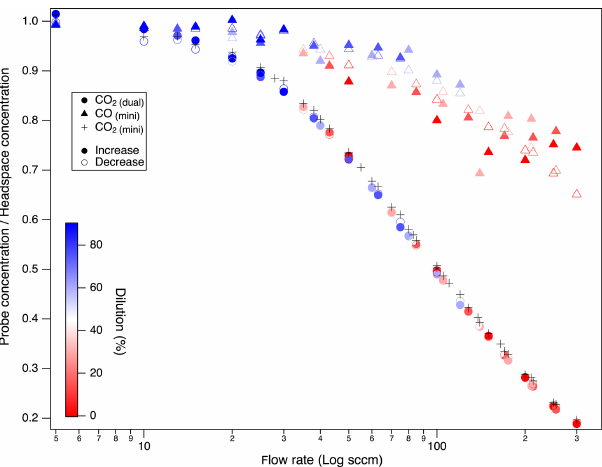
Figure 7. Impact of probe sampling flow rate on the fractional re- covery of true gas concentrations by probe gas sampling for trace gases with differing diffusivity (CO > CO 2 ), represented as the fractional recovery (probe:headspace concentration ratio) during a test with a sequential increase in the probe flow rate (forward in filled symbols) followed by a test decreasing (reverse in open sym- bols) the flow rates. Dilution-corrected CO 2 and CO in System